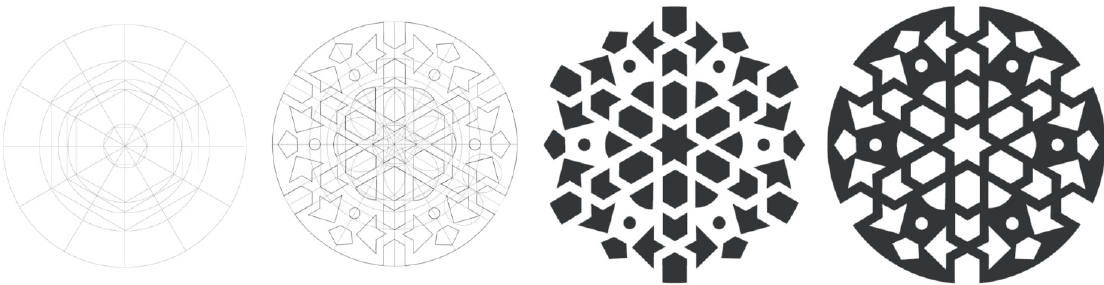
Figure 1. Figure-Ground